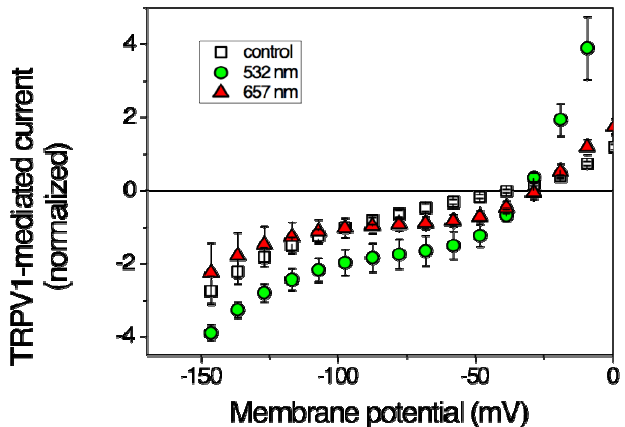
Figure 1. Effects of laser light on steady-state current-voltage curves of TRPV1-mediated current in Xenopus oocytes. Open squares represent data in the absence of irradiation (control), filled symbols at the end of a 2-min-lasting irradiation period of 637 nm (triangles up, 36 mW) and of 532 nm (circles, 40 mW), respectively at a power density of <500 mW/cm 2 . Data are